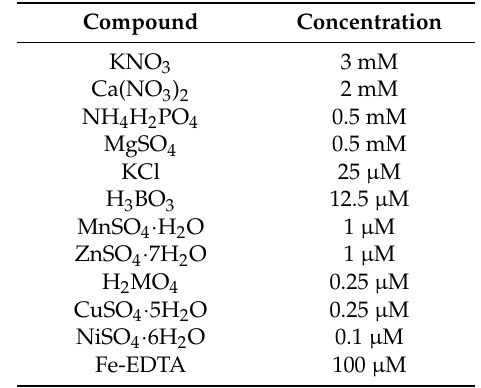
Table 1. Composition of full-strength nutrient solution